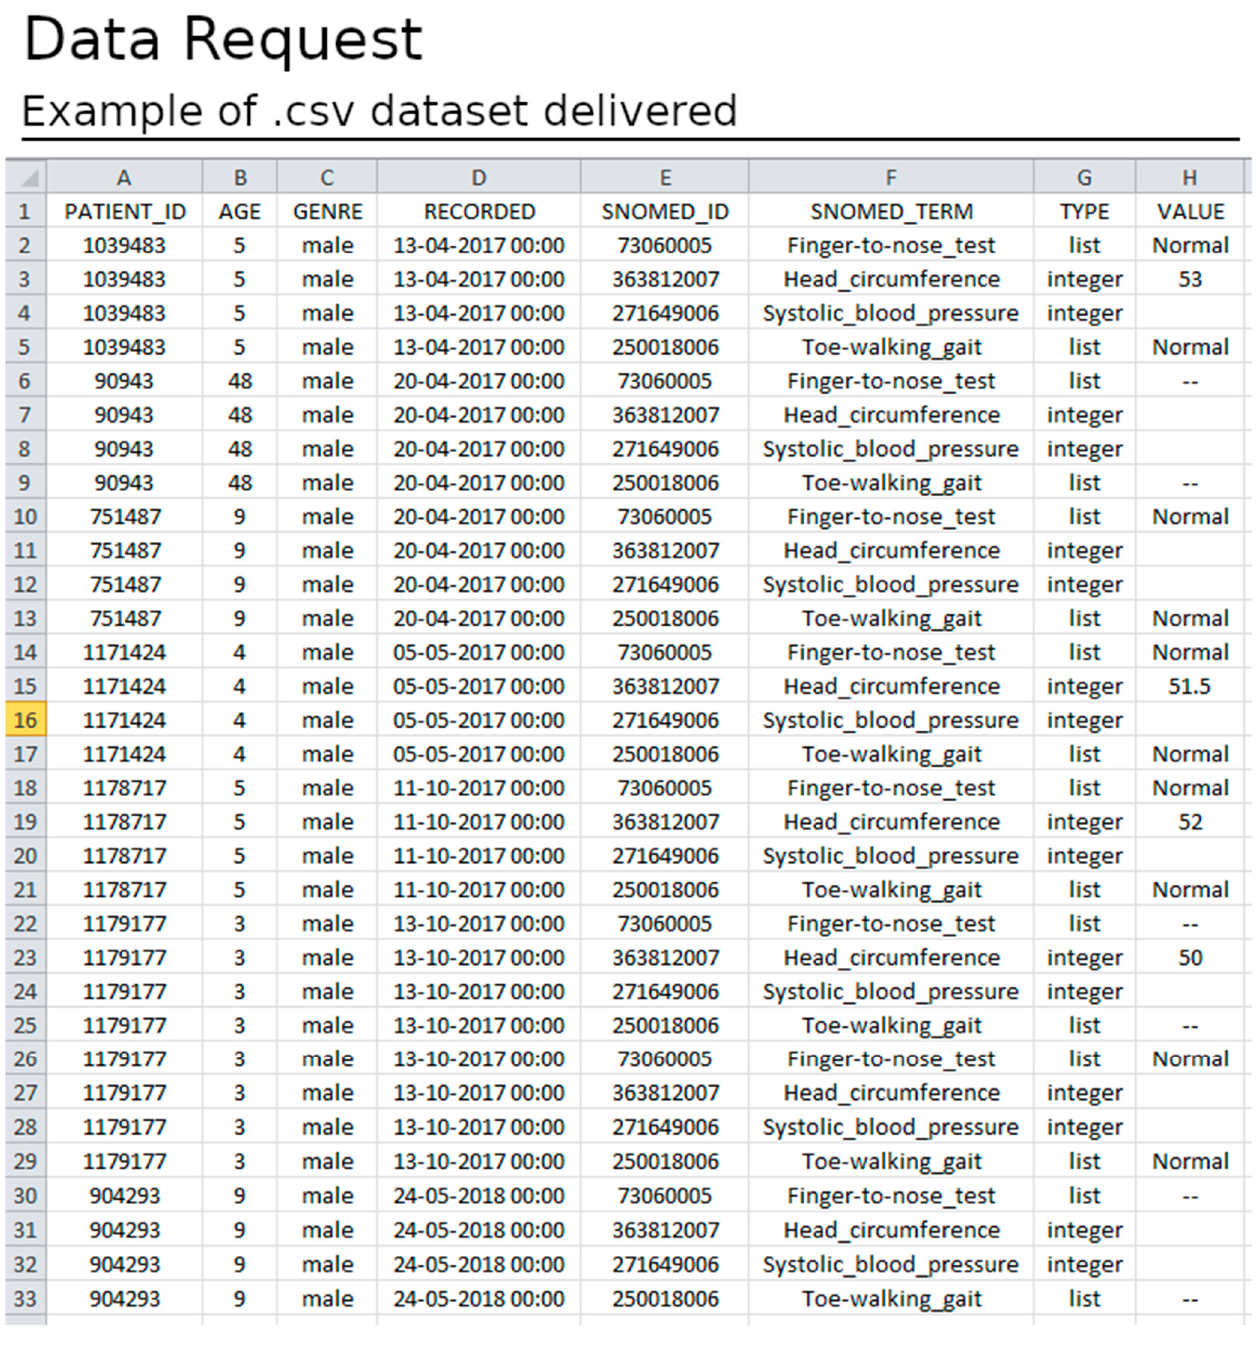
Figure 12. Example of a dataset obtained by a data request. The dataset is delivered in .csv long format (one record per line). The dataset is composed of several columns with metadata (the patient’s unique ID, the age of the patient, the sex of the patient, the date when the value was recorded, the SNOMED ID, the SNOMED definition, and the data type of the value) about the value recorded in the column VALUE.